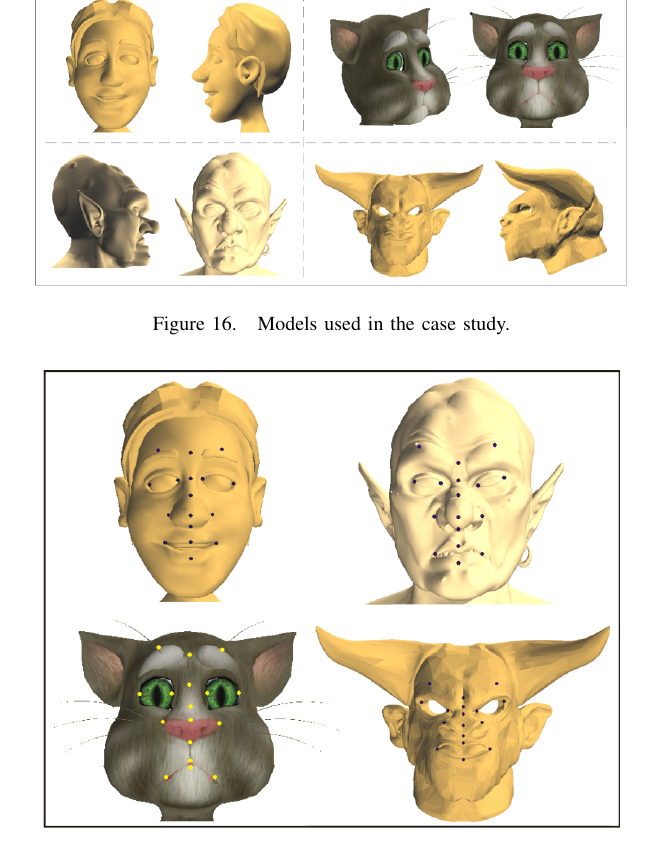
Figure 17. Identification of anthropometric landmarks in the new